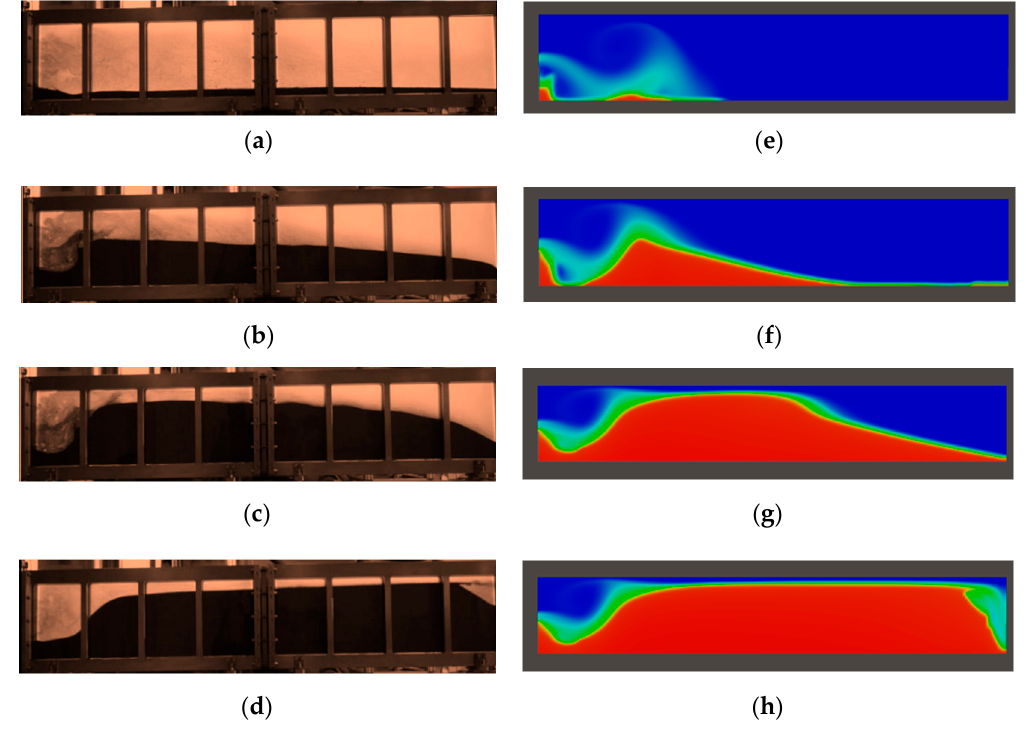
Figure 5. Experimental and numerical simulation results of proppant transport and settlement process. ( a – d ): Proppant placement in the experiment process; ( e – h ): Corresponding proppant placement in